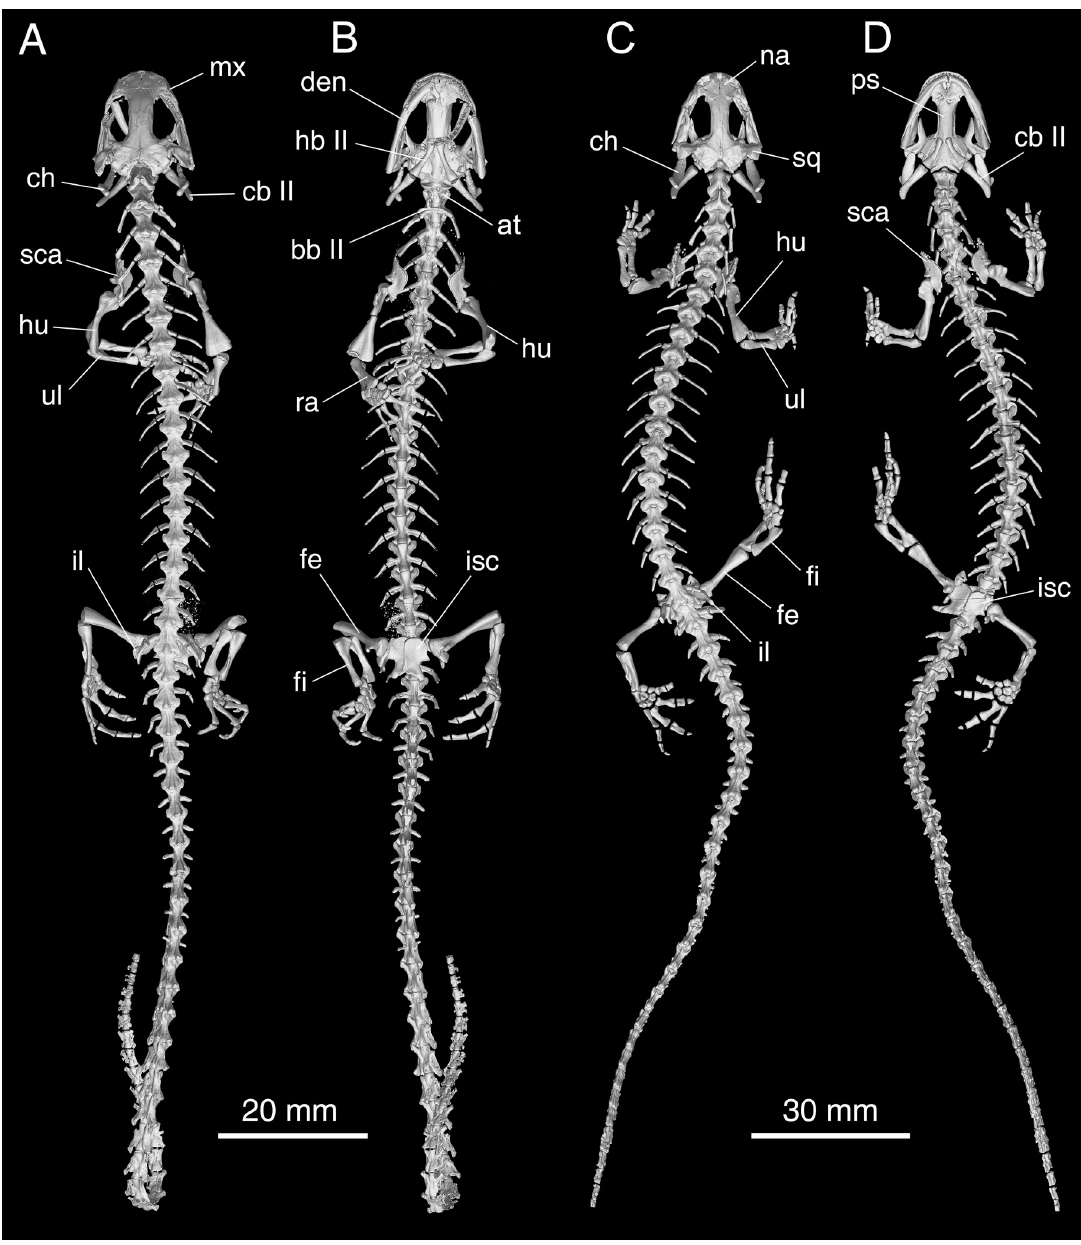
Fig 8. Micro-CT rendered reconstructions of the whole body skeleton of Batrachuperus yenyuanensis . A, B, CIB 17308 in dorsal (A) and ventral (B) views; C, D, CIB 72599 in dorsal (C) and ventral (D) views. CIB 17308 from Shuangertang, Yanyuan County; CIB 72599 from Tuowu, Mianning